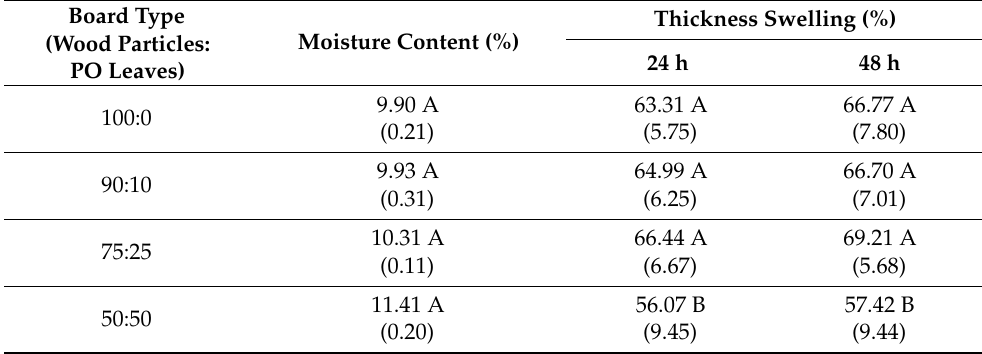
Table 2. The physical properties of various board types. Standard deviations are given in parentheses. The different letters show which values are statistically different at the 5%